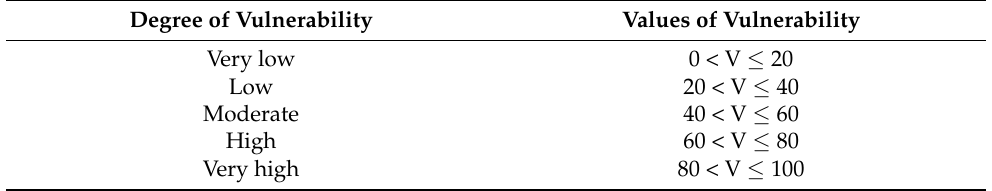
Table 5. Degree and values of vulnerability [31].